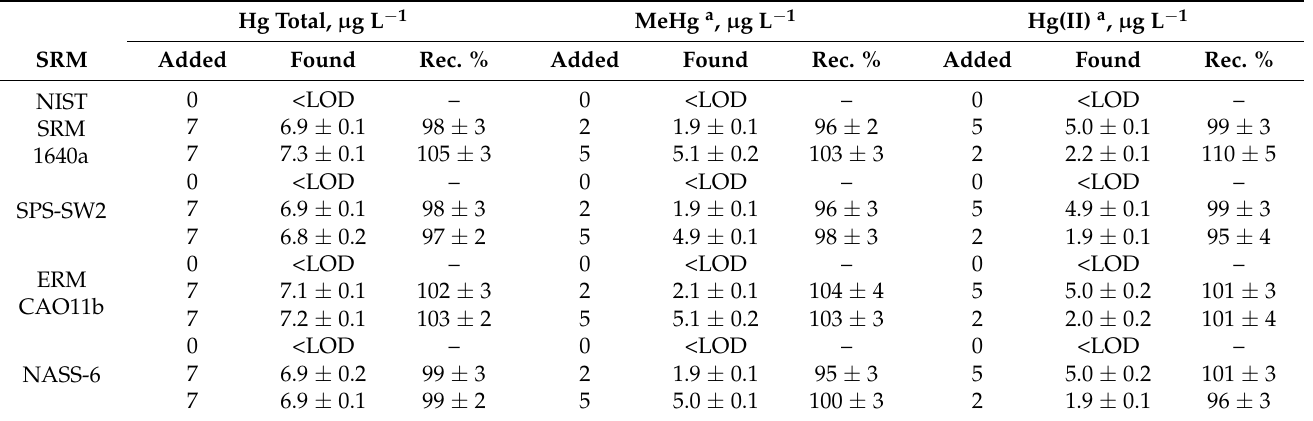
Table 3. Total mercury, Hg(II) and MeHg in water reference materials (SRM).